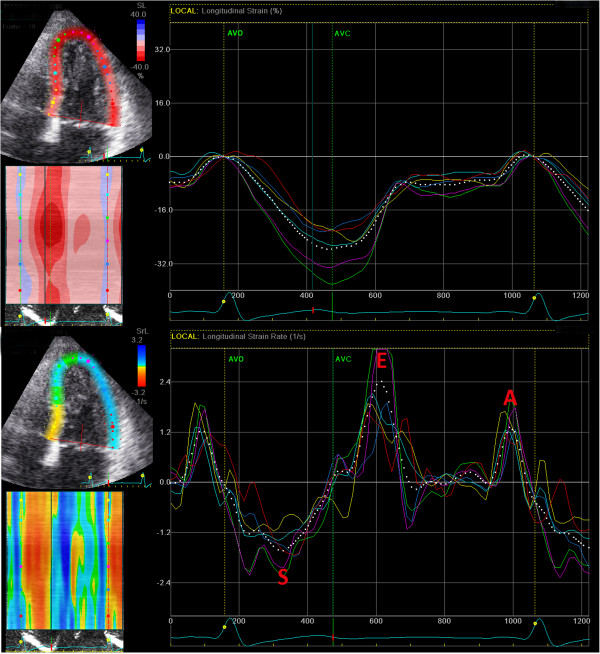
Longitudinal strain and strain rate imaging by 2D speckle tracking for the apical 4-chamber view. The top panel is the strain throughout one cardiac cycle for each of the color coded LV segments (mean strain shown by dotted white line). In this example, the mean peak strain is about 27% which occurs during LV ejection, defined as the interval between aortic valve opening (AVO) and closure (AVC). The bottom panel shows the corresponding LV strain rate. Note the negative strain rate in systole (S) and the positive strain rates (E during early diastole, and A during late diastole).